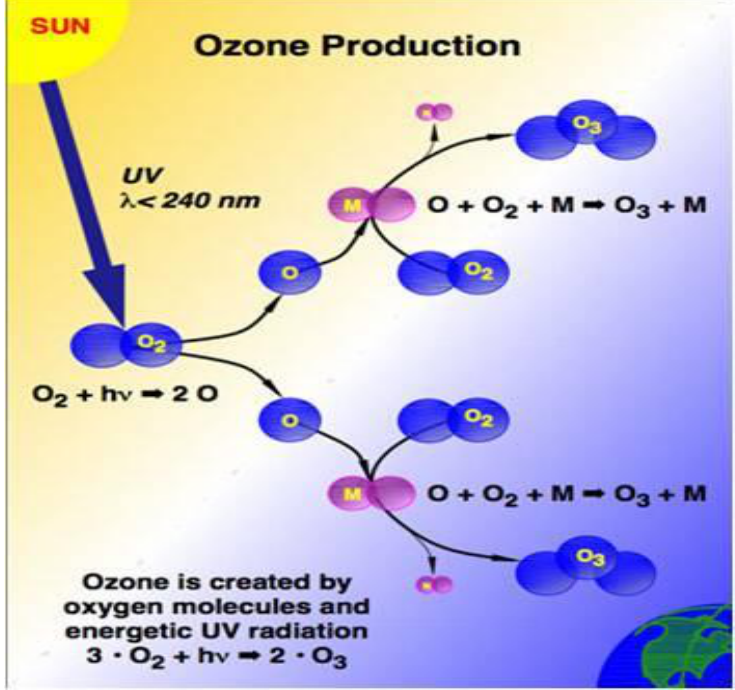
Figure 1. Ozone Production. Ozone is created by oxygen molecules and energetic UV radiation [9].